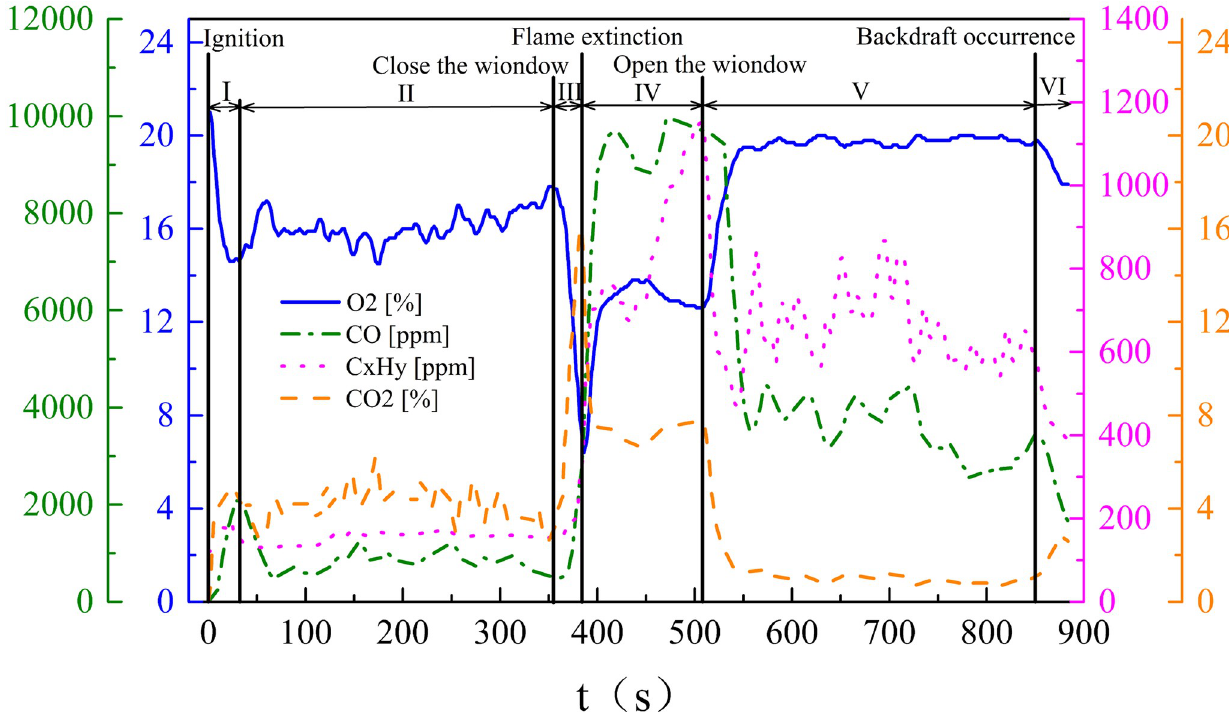
Fig 5. Gas component concentration curves of Test 8: (I) alcohol burning; (II) woodblocks steadily burning; (III) woodblocks transition from complete burning to incomplete burning; (IV) woodblocks smoldering; (V) gas exchange and intense smoldering; (VI) woodblocks steadily burning